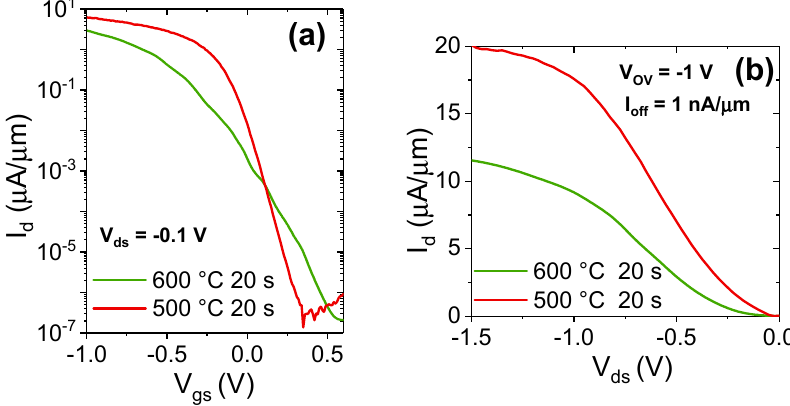
Figure 3. Measurement results of Set 1 devices. ( a ) I d -V g transfer characteristics for p-TFETs annealed at two different activation temperatures. ( b ) I d -V ds output characteristics for the corresponding devices, showing the super-linear onset of the I d -V ds curves.